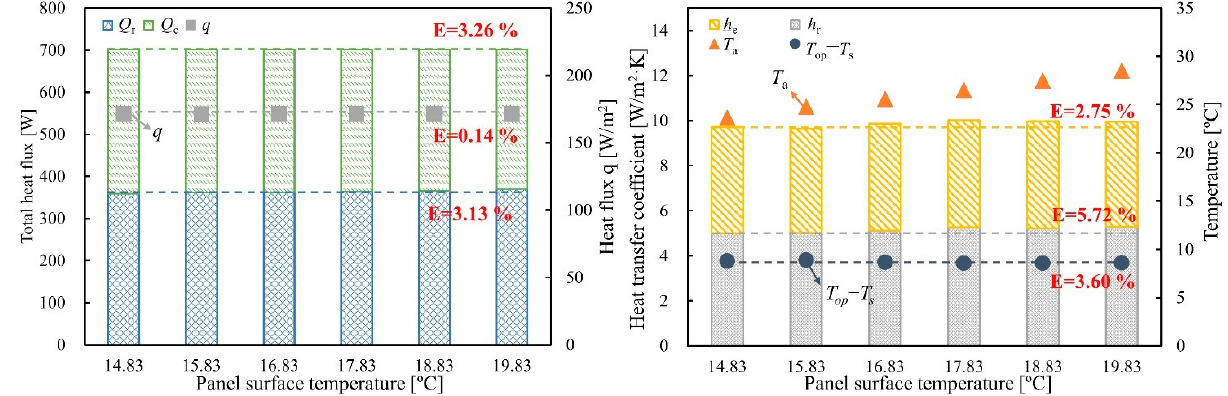
Figure 5. Calculation results under different panel surface temperatures.